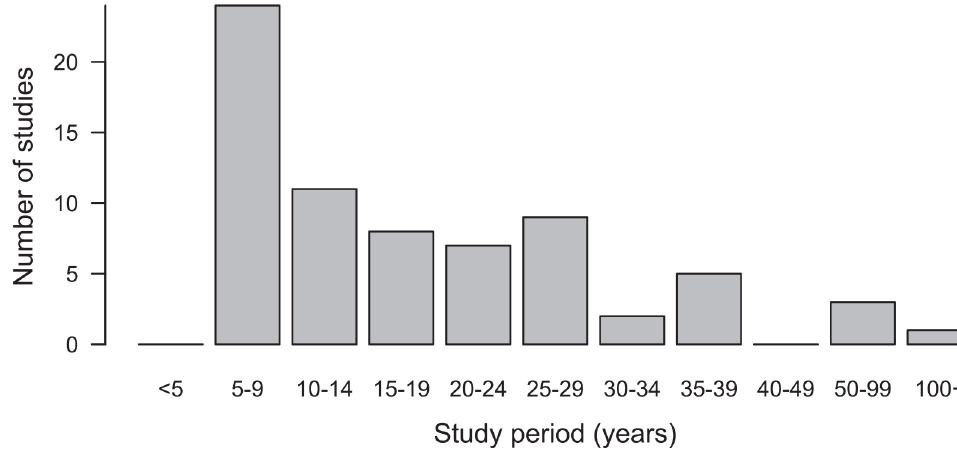
Fig 2. The study periods of the 70 data packages included in the survey for which this could be